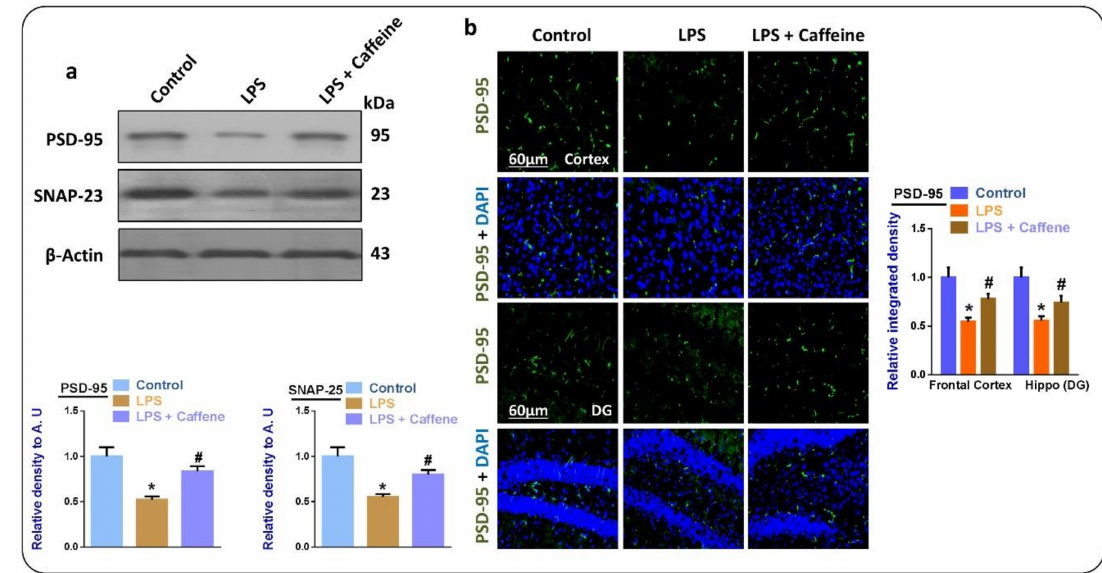
Figure 5. Ca ff eine inhibits synaptic dysfunction in LPS-injected mouse brains: ( a ) Western blot results of PSD-95 and SANP-23 in the brains of the experimental mice ( n = 10 mice per group; number of experiments = 3; statistical analysis used was one-way ANOVA with Tukey’s posthoc test for comparisons among the di ff erent groups); ( b ) immunofluorescence images of PSD-95 in the experimental groups, magnification 30 × , scale bar 60 µ m. * significantly di ff erent from the vehicle-treated control group, # significantly di ff erent from the LPS-treated group. Significance: * p < 0.05; # p < 0.05. DAPI: 4 (cid:48) , 6-diamidino-2-phenylindole. DG: Dentate